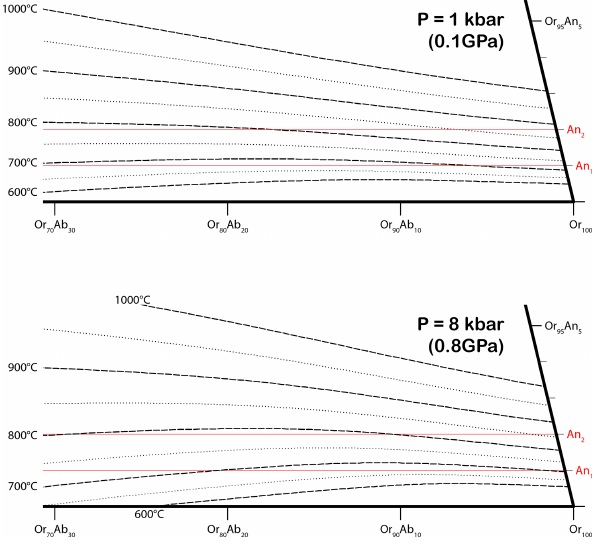
Figure 11. Solvi of the ternary feldspar between 600 and 1000 ◦ C with a 50 ◦ C interval at P = 1kbar (0.1GPa) and P = 8kbar (0.8GPa), calculated with SOLVCAL (Wen and Nekvasil, 1994) using the parameters of Elkins and Grove (1990). The composition line with 1mol% and 2mol% An are marked with horizontal red lines. The An dimension is stretched for better separation between adjacent solvi. The more recent parameters of Benisek et al. (2010) are not used because they create a large discrepancy with the well- established binary solvus in the Ab–Or join.